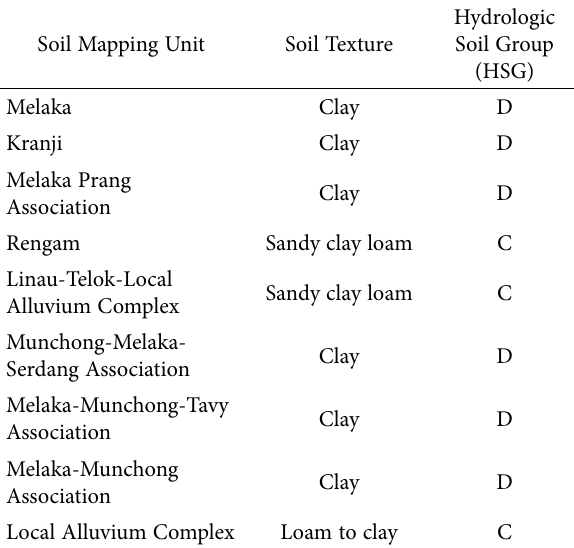
Table 2. Hydrological soil group classification of Melaka Tengah catchment